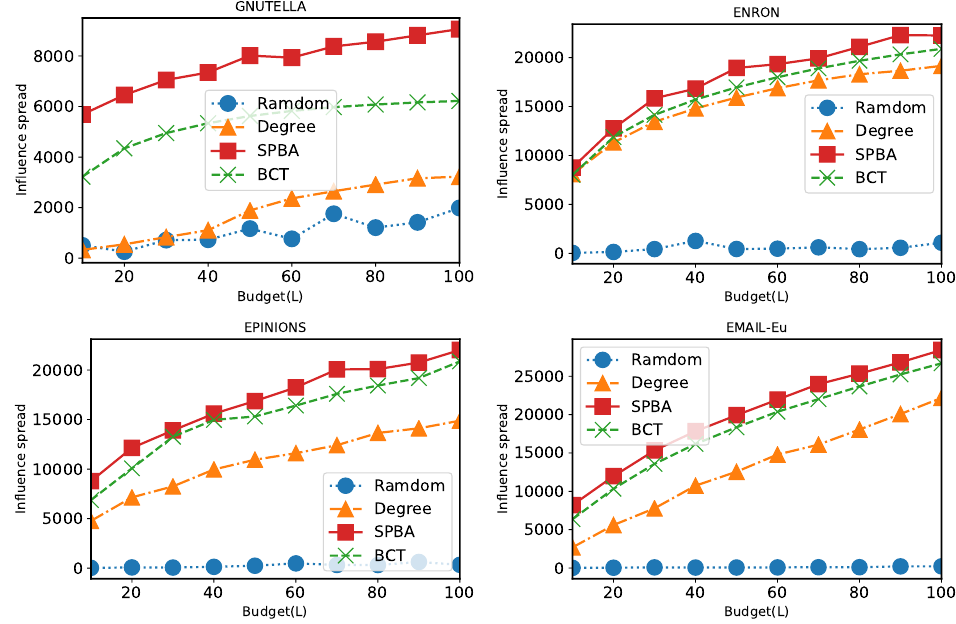
Figure 7. Comparison between different algorithms under unit-cost